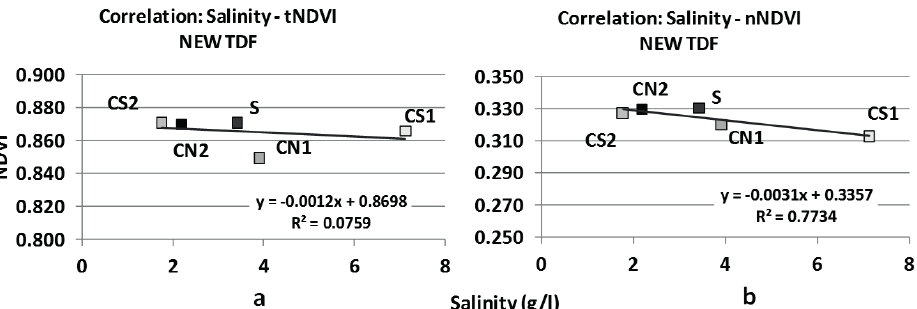
Fig. 5 Linear correlation between average salinity values and average tNDVI (a) and nNDVI (b) values of NEW TDF